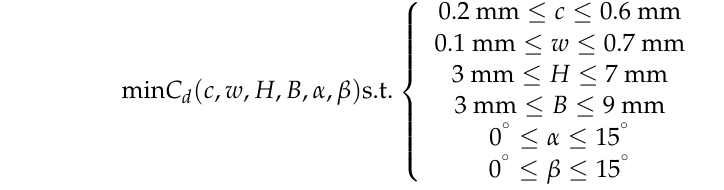
Figure 8a, by optimization, C d decreased from 0.403 to 0.267, and the optimal design parameters were 0.202 mm, 0.103 mm, 6.950 mm, 8.991 mm, 0.007 ◦ , and 14.994 ◦ . In the second optimization process, the initial values of c , w , H , B , α , and β were 0.5 mm, 0.3 mm, 7 mm, 4 mm, 12 ◦ , and 0 ◦ . As shown in Figure 8b, by optimization, C d decreased from 0.509 to 0.266, and the optimal design parameters were 0.212 mm, 0.105 mm, 6.989 mm, 8.930 mm, 0.009 ◦ , and 14.989 ◦ ). This illustrates that the effects of initial values on optimization results were